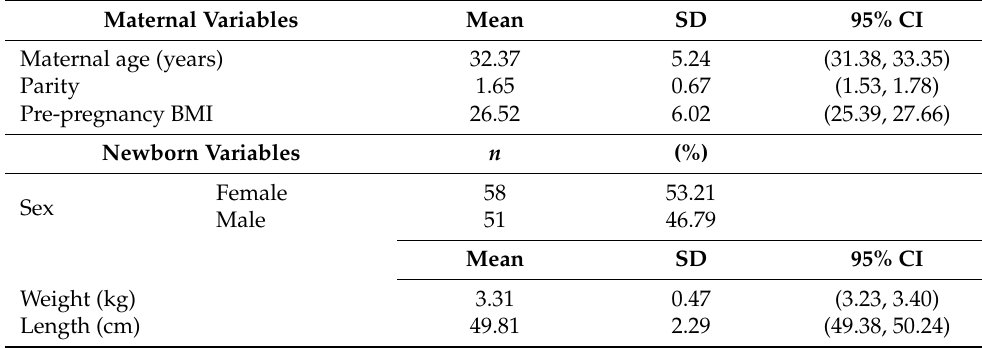
Table 1. Characteristics of the study population ( n =